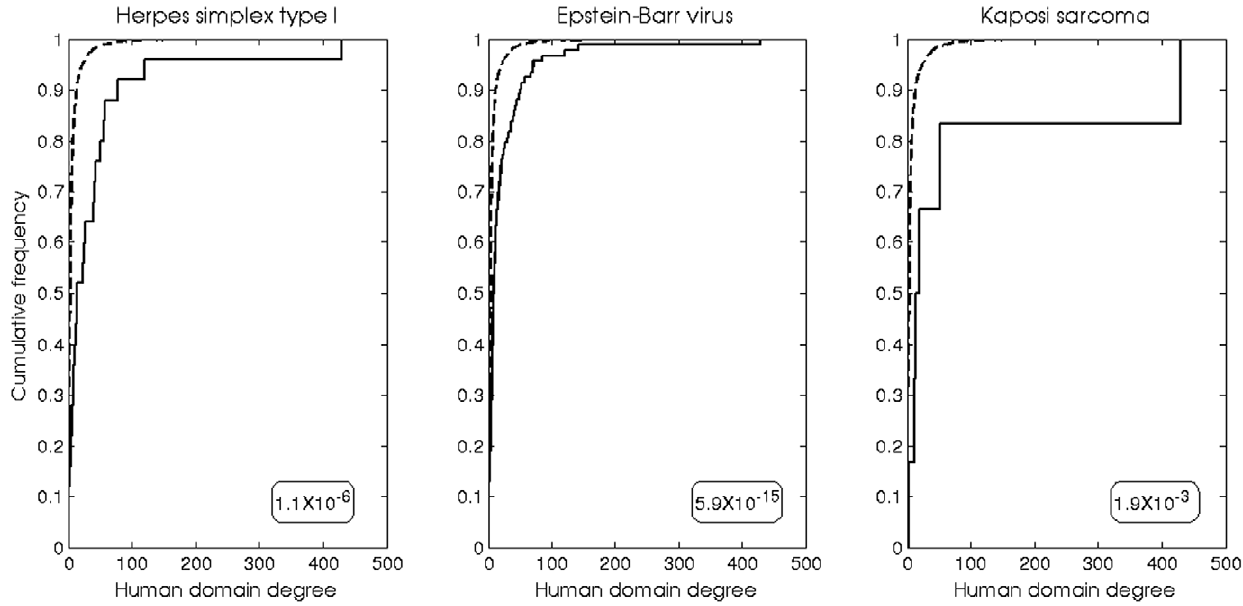
Figure 1. Herpesviruses domains tend to interact with human hub domains. Comparison between the degrees of human domains targeted by viral domains (‘‘target’’, solid lines) and the degrees of human domains that were not found to be targeted by viral domains (‘‘non target’’, dashed lines). The human domain degrees were calculated according to the human single-domain PPI network (see text). Human domains that are targeted by the viral domains have a higher degree than the human domains that are not targeted by the viral domains. These finding are statistically significant by a Kolomogorov Smirnof (p-values are given in rounded box at the right bottom of each graph). doi:10.1371/journal.pone.0021724.g001 PLoS ONE |